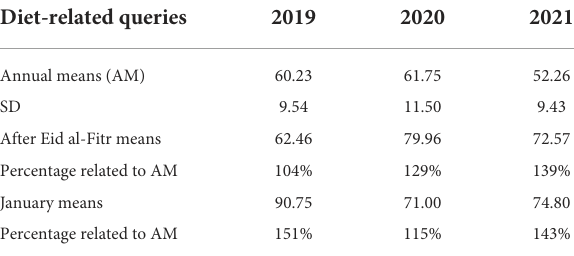
TABLE 4 The Comparison between after Eid al-Fitr and after the new year with annual diet-related queries means. Diet-related